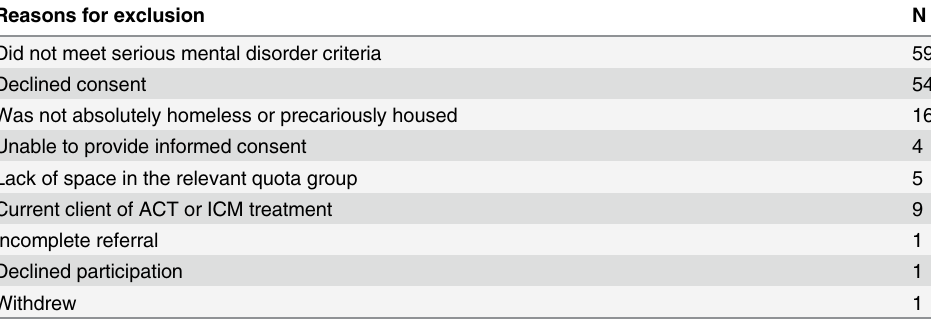
Table 2. Reasons for exclusion at the screening interview (n = 151